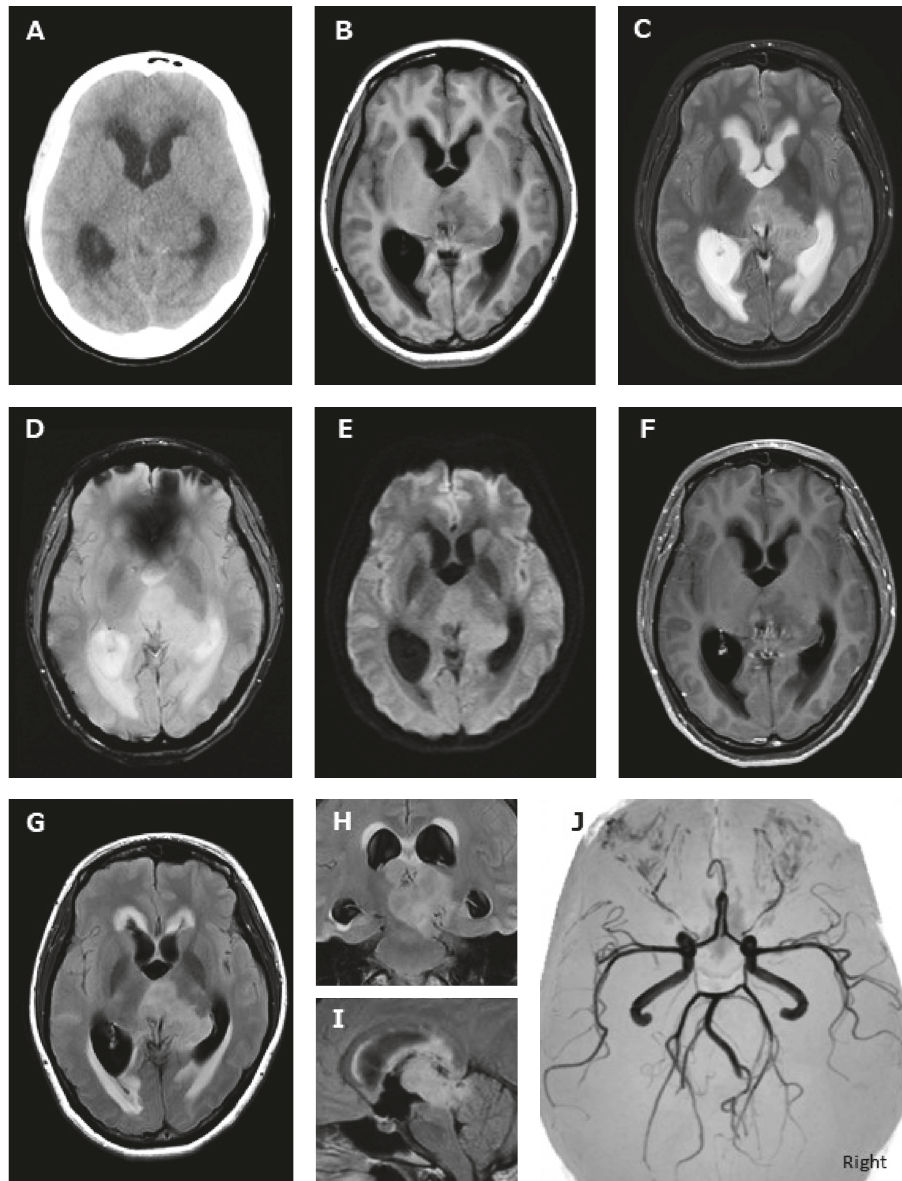
Figure 1: CT imaging revealed hydrocephalus and an iso-density mass lesion at the left thalamus (A). MRI revealed imaging revealed a poorly circumscribed mass lesion in the left thalamus, extending to both the midbrain and the right thalamus. The signal patterns were T1-low (B), T2-high (C), T 2 ∗ -high (D), diffusion weighted image-slight high (E), T1 Gadrinium-nonenhanced (F), and fluid attenuation inversion recovery-high (G; axial, H; coronal, I; sagittal), respectively. MRA showed no obvious vascular abnormalities (H).